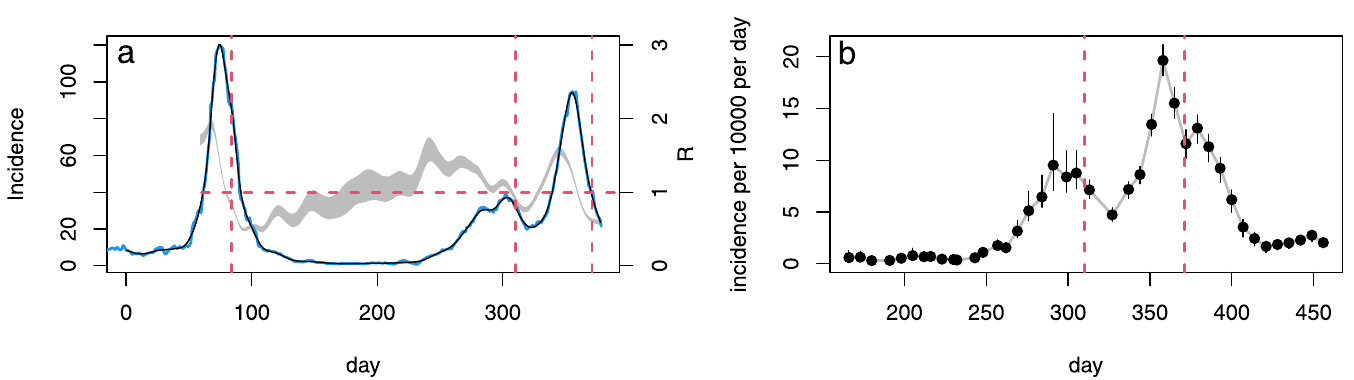
Fig 7. a . continuous curves are onset of new symptoms per day from the REACT-2 study digitized from [29], and lagged by the average 5.8 days from infection to first symptoms to give incidence: blue is raw and black is spline smoothed. Jan 1 2020 is day 1 and vertical dashed red lines show the lockdown dates. The grey band shows a 95% credible interval for R reconstructed from the smoothed incidence curve by the method given in section 5.1 of [28]. The horizontal dashed line shows R = 1. Incidence peaks about 9 days prior to lockdown 1 (day 84, March 24th 2020), and R < 1 four days before lockdown 1. b . [30] published estimated incidence with 95% confidence limits. Red lines show the dates of the second and third UK lockdowns—the survey was not running at the first.